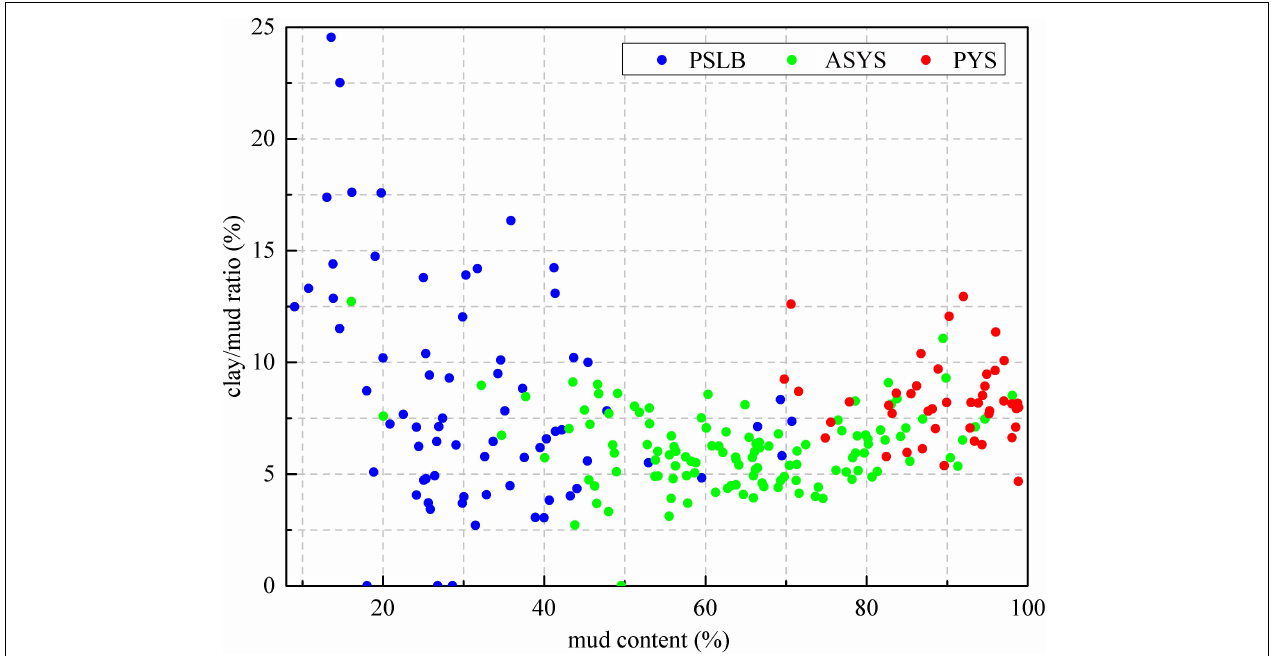
FIGURE 5 | The bivariate plot between the mud content and clay/mud ratio of the tidal flat surficial sediments along the southern abandoned Yellow River sub-delta and adjacent zones.